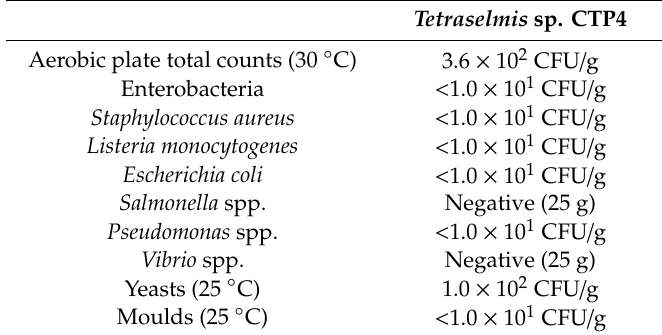
Table 7. Microbiological evaluation of Tetraselmis sp. CTP4 biomass grown semi-continuously in industrial tubular photobioreactors. CFU = colony-forming unit.